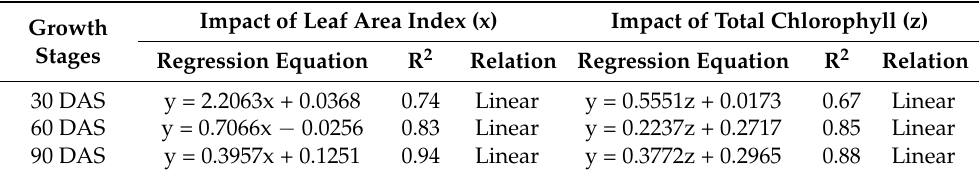
Table 6. Impact of leaf area index (x) and total chlorophyll (z) on cumulative intercepted PAR